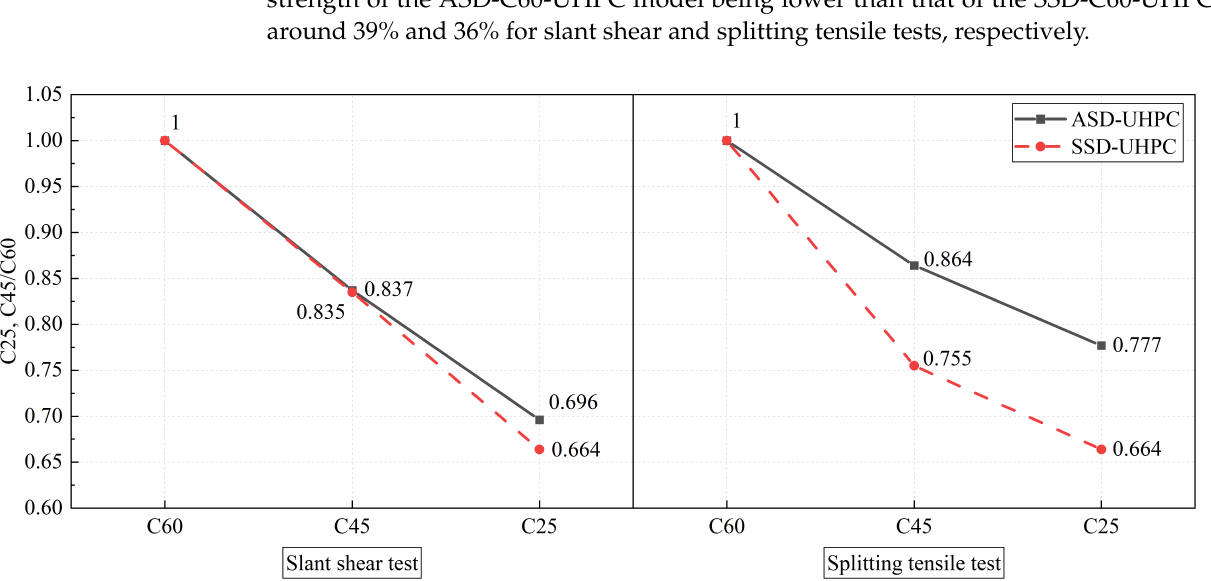
Figure 6. Effects of the substrate strength on the interfacial bond